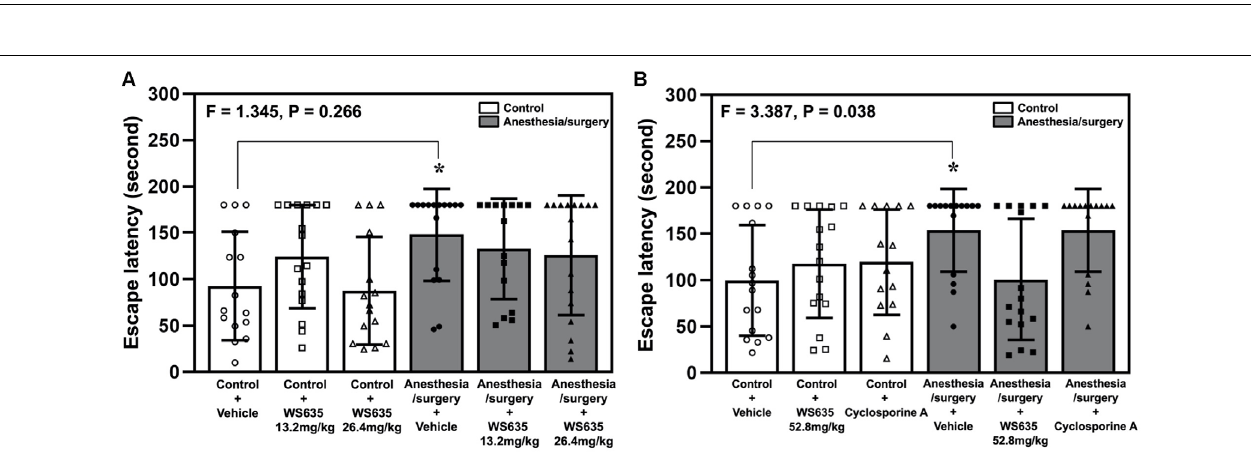
FIGURE 3 | Effects of WS635, CsA, and the anesthesia/surgery on locomotor activity in mice. Effects of WS365 with 13.2 mg/kg and 26.4 mg/kg (A–C) and effects of WS365 with 52.8 mg/kg and CsA with 10 mg/kg (B–D) on escape speed of Barnes maze on training days (7–10 days after the anesthesia/surgery) in mice following control condition or anesthesia/surgery. N = 14–18 mice in each group.